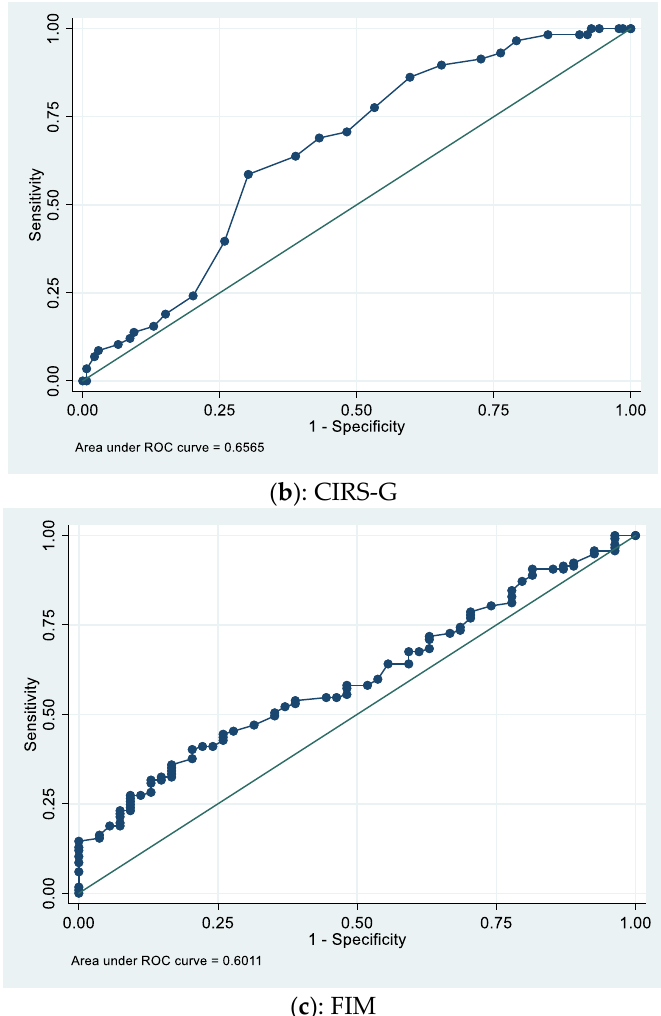
Figure 1. ROC (receiver operating characteristic) curves for pneumonia 1-year mortality: ( a ) MNA area under the curve = 0.70. Optimal cut-off point: 8; ( b ) CIRS-G area under the curve = 0.66. Optimal cut-off point: 26; ( c ) FIM area under the curve = 0.60. Optimal cut-off point: 64.